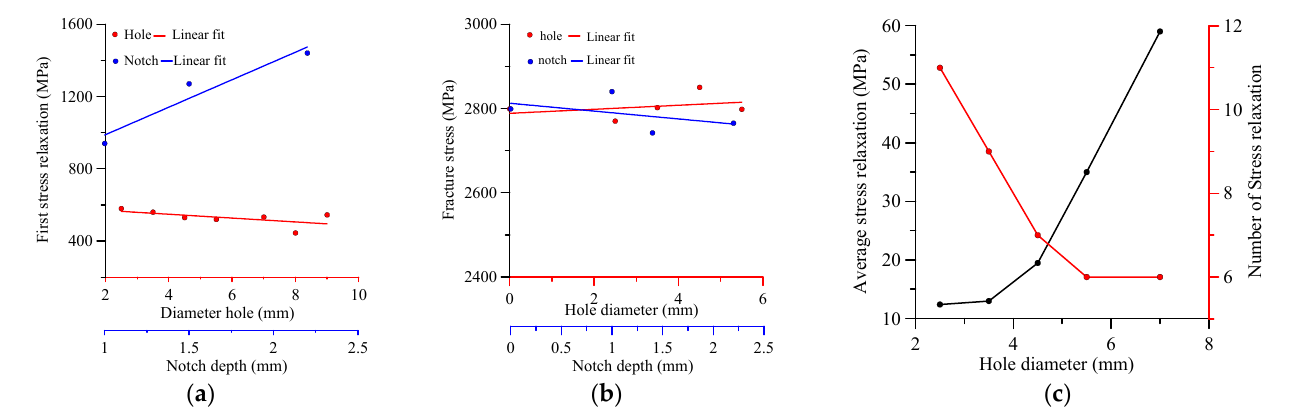
Figure 21. The hole and the notch effect on the mechanical response in tension; ( a ) first stress relaxation vs. hole diameter and notch depth; ( b ) fracture stress; ( c ) the amount and the number of stress relaxations. Table 8. Comparison of mechanical properties between tension and compression of uniform